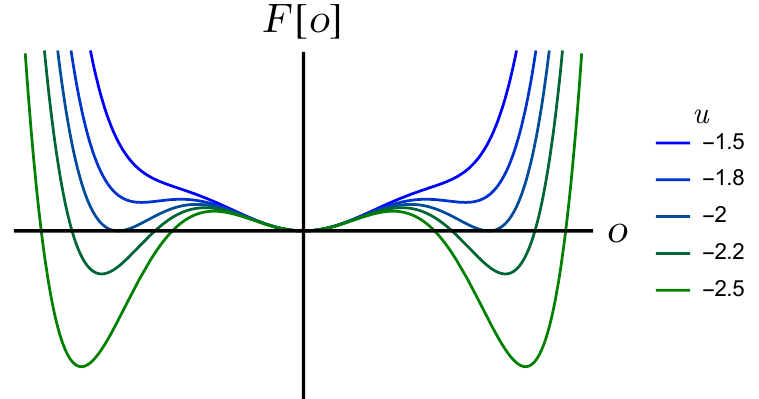
Figure 5.3: The Landau free energy as a functional of the order parameter o during a discontinuous phase transition described by Eq. (5.5), with r = w = 1, for several values of u . The location of the minimum of F as u crosses the value −